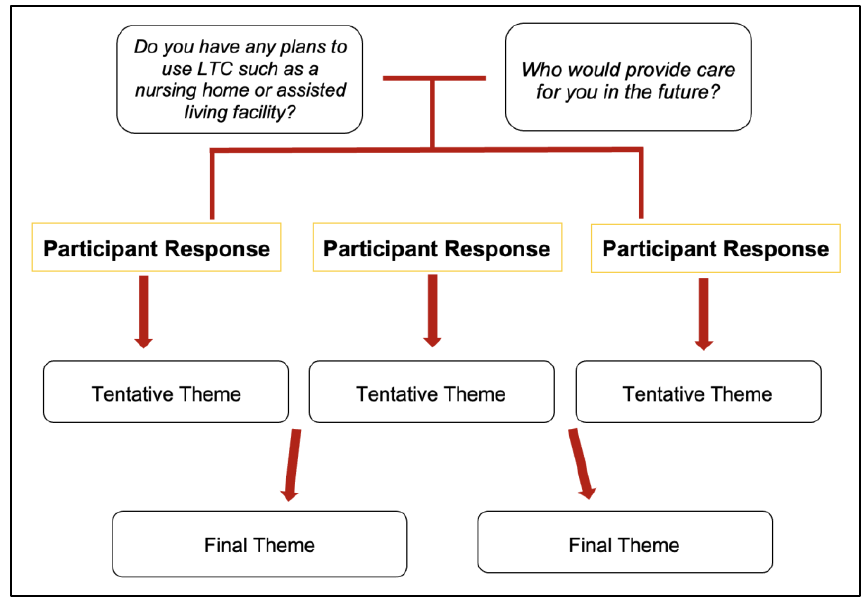
Figure 1. Coding Illustration .